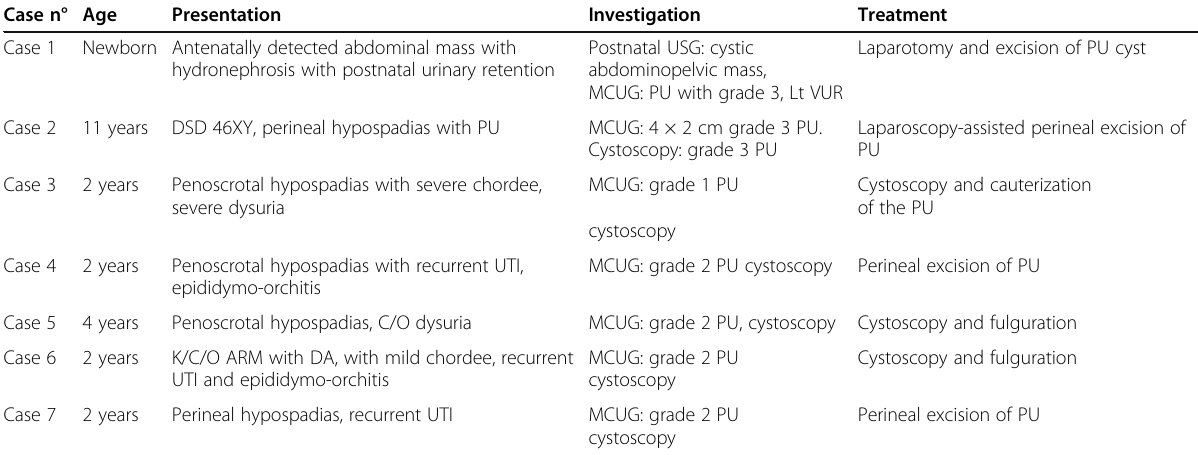
Table 1 Clinical presentations and surgical approaches to treat a symptomatic prostatic utricle